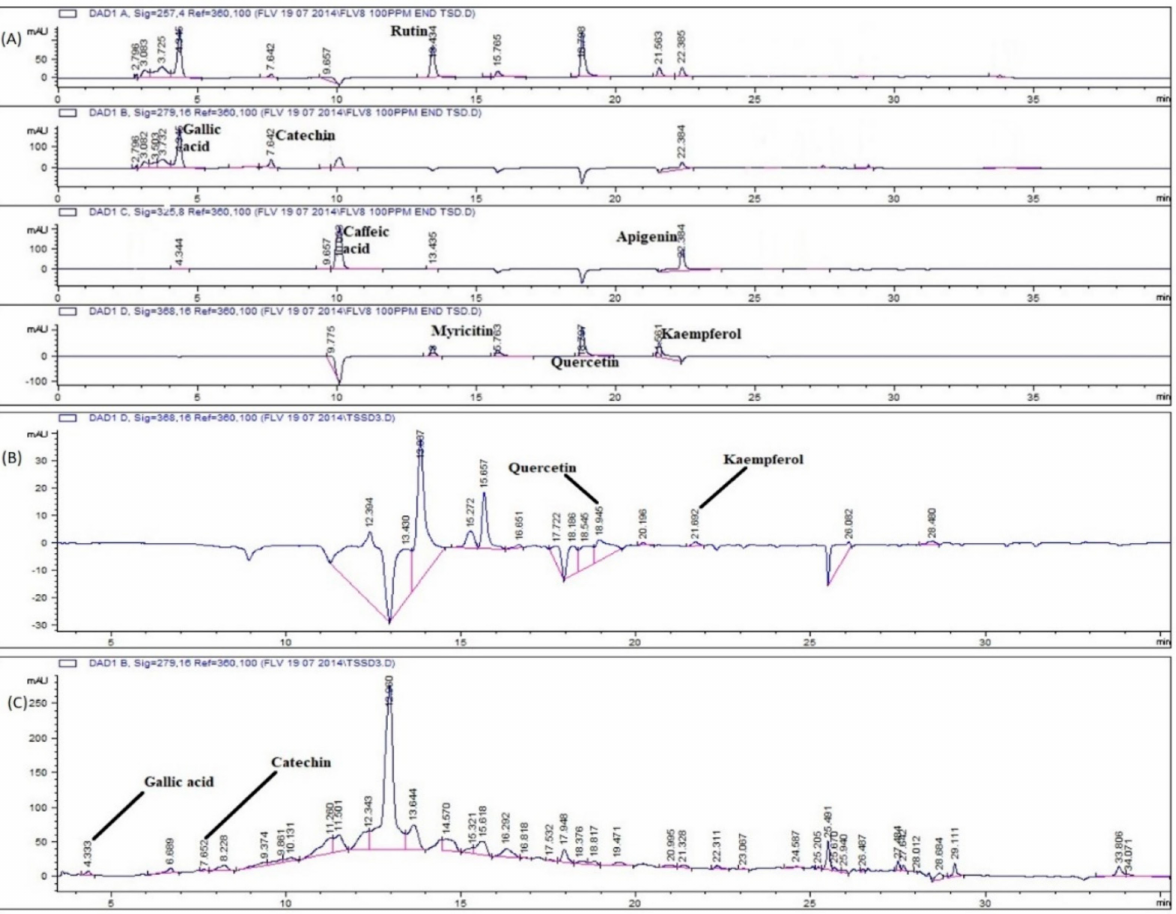
Figure 3. HPLC chromatograms of ( A ) standard polyphenols, ( B , C ) AC:M seeds extract of P. glabrum